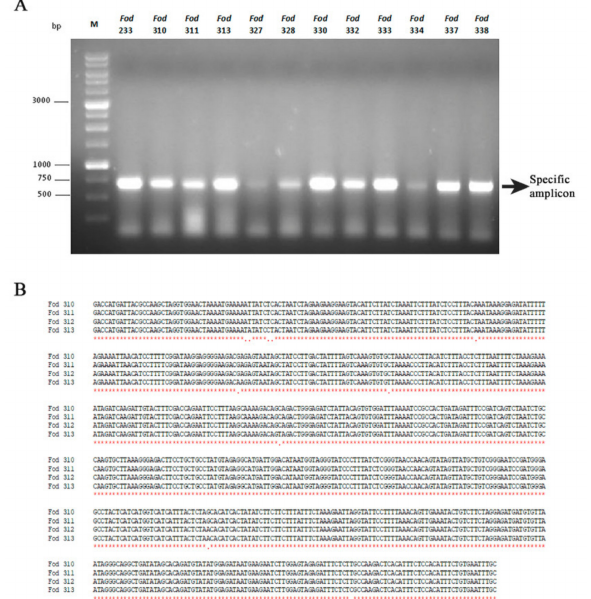
Figure 6. Isolates of Fusarium oxysporum f. sp. dianthi infected with mitovirus FodMV1, and alignment of the partial nucleotide sequence of the RdRp of FodMV1 from di ff erent isolates. ( A ) Specific amplicons obtained after RT-PCR of the dsRNA extracts using specific primers for the RdRp sequence of FodMV1. M: 1 kb molecular weight marker (Nippon Genetics, Japan). ( B ) Multiple alignment of the amplicons obtained by RT-PCR using specific primers for the RdRp of FodVM1 and dsRNA extracts from isolates Fod 310, 311, 312, and 313 of Fusarium oxysporum f. sp. dianthi from Colombia. Analysis was carried out with the program MAFFT